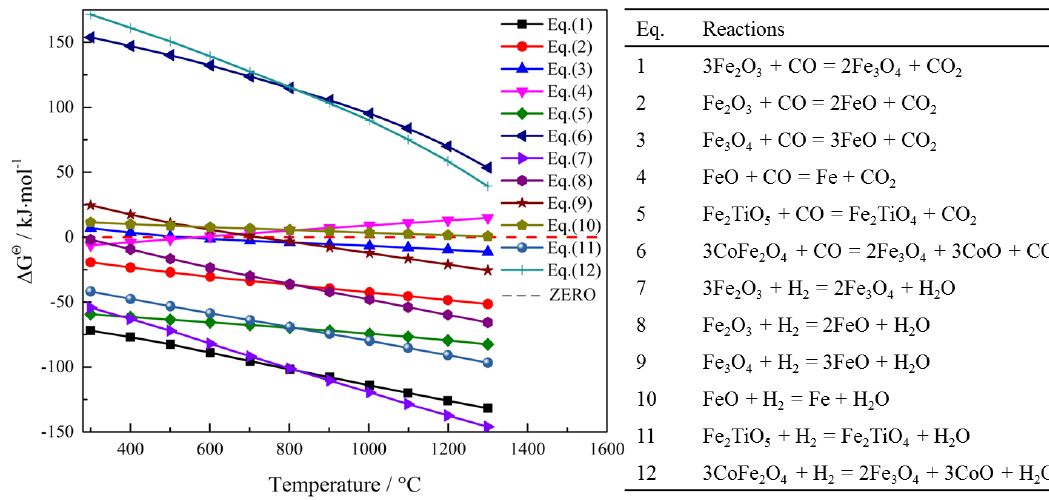
Figure 13. Relation between ∆ G and T for CVTP possible reduction reactions.